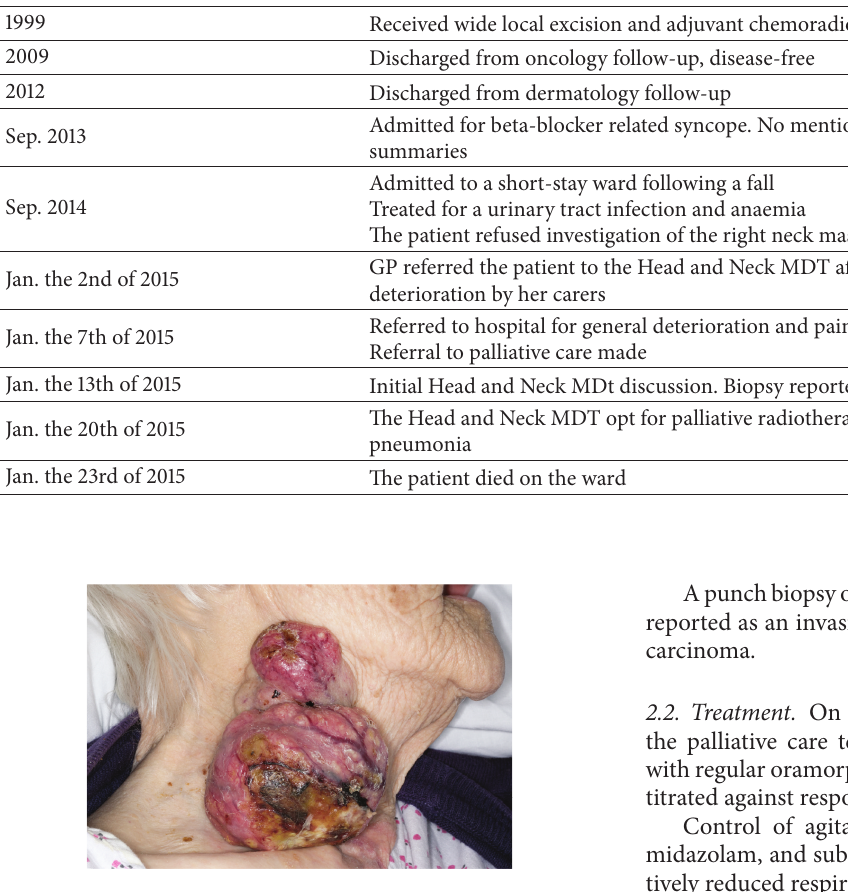
Figure 1: A lateral view of the